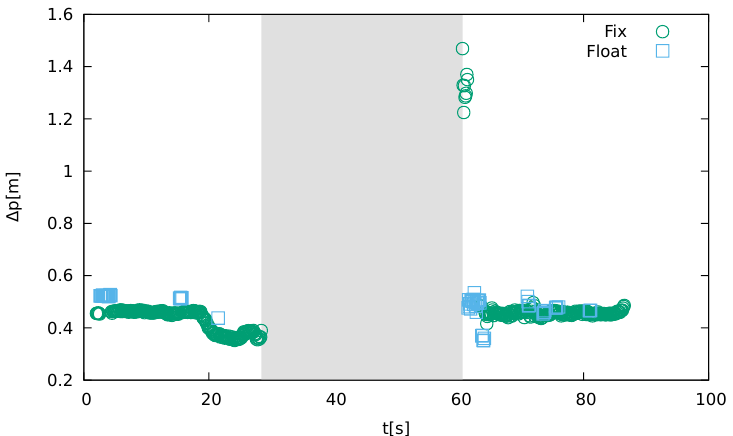
Figure 16. Time dependency of the position displacement for Leica GS15 using GPS and Galileo. For the sake of clarity, only the affected drive is shown. The shadowed region is 32.2 s wide and represents the region with no solutions at all (own